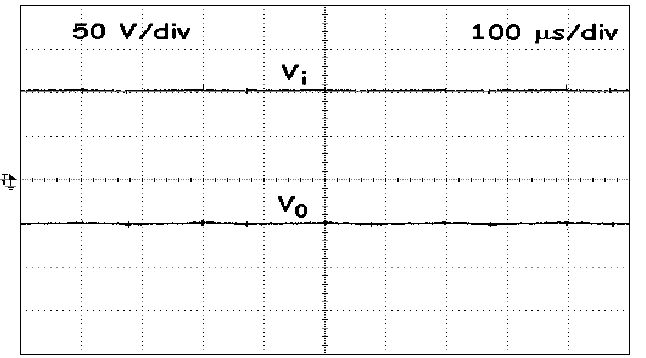
Figure 16. Experimental results for the input and inverted output voltage in buck mode.